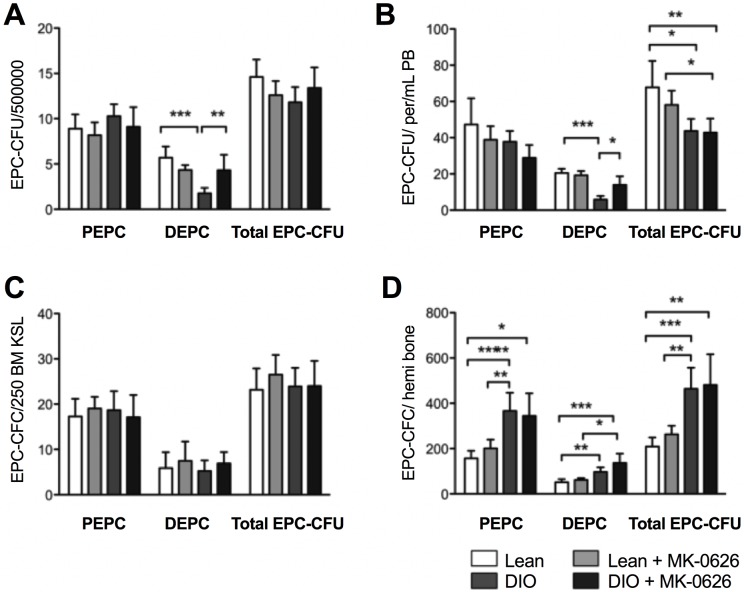
MK-0626 enhances EPC differentiation in vivo.Colony number of pEPC-CFUs and dEPC-CFUs generated from 5 × 105 cells of BM (A), 1 mL of peripheral blood (B), 250 cells of BM-KSL (C) and hemi bone (D). The individual bars indicate cells from healthy mice (open), MK-0626-administered healthy mice (light gray), DIO mice (dark gray) and MK-0626-administered DIO mice (black). Data are represented as the mean ± SE. N = 6 mice per group. Experiments were repeated twice. In the graph, *P < 0.05, **P < 0.01, ***P < 0.001, and ***P < 0.0001 as determined by Two-way ANOVA followed Tukey’s multiple comparisons test.